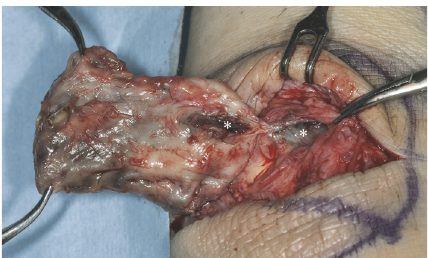
Figure 5: An intraoperative photograph of the resected bursa. The bursal cavity was in communication with the tendon sheath of the extensor digitorum longus